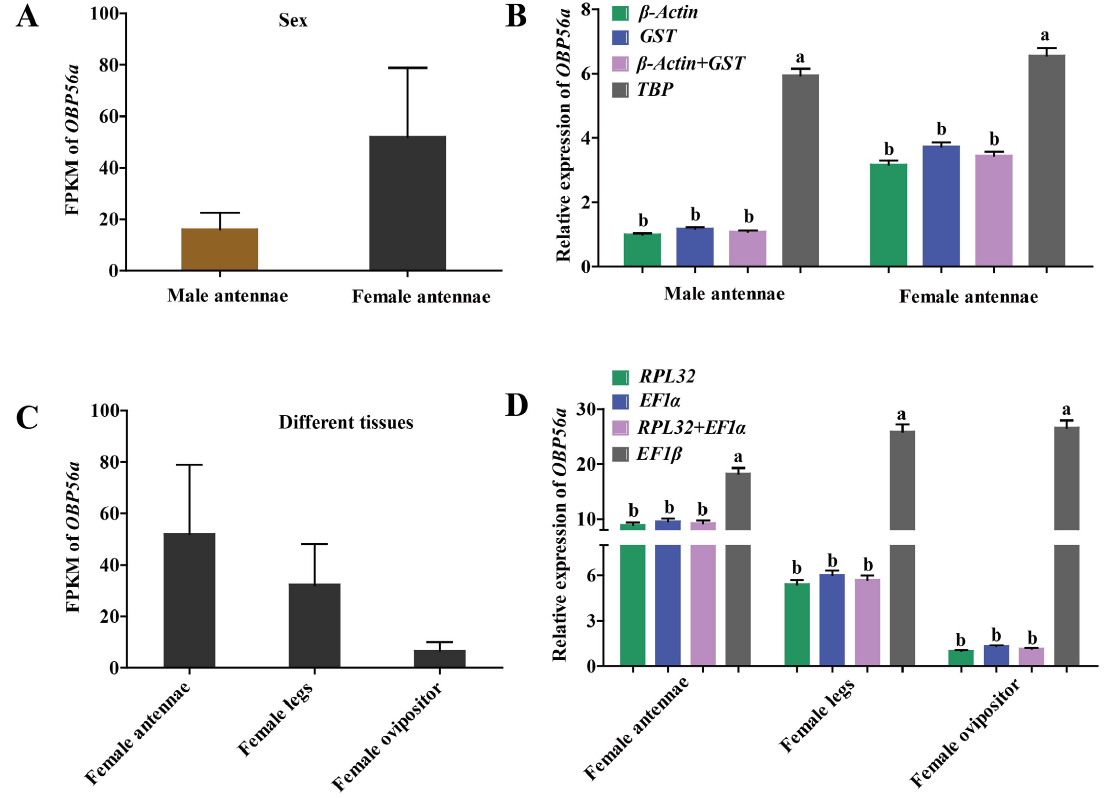
Figure 6. The expression profiles of OBP56a in both sexes and in different tissues of N. asiatica adults. ( A ) The expression levels of OBP56a in the antennae of male and female flies presented by the FPKM value of transcriptome data. FPKM: fragments per kilobase of exon model per million mapped reads. ( B ) The expression levels of OBP56a in male and female antennae by qPCR. The expression levels of OBP56a in male antennae were used for normalization. Namely, the relative expression levels were presented as fold changes relative to the transcript levels of OBP56a in the male antennae. β-Actin , GST , and β-Actin + GST were used as the one or two most stable reference genes. TBP was used as the least stable reference gene. ( C ) The expression levels of OBP56a in different tissues (female antennae, female legs, and female ovipositor) presented by the FPKM value of transcriptome data. ( D ) The expression levels of OBP56a in female antennae, female legs, and female ovipositor by qPCR (most stable RGs: RPL32 and EF1α , least stable RG: EF1β ). The OBP56a expression in female ovipositor was used for normalization. Data are represented as the mean ± SE . Bars labeled with different letters are significantly different ( p < 0.05, ANOVA followed by Tukey’s HSD multiple comparison test, n = 3).